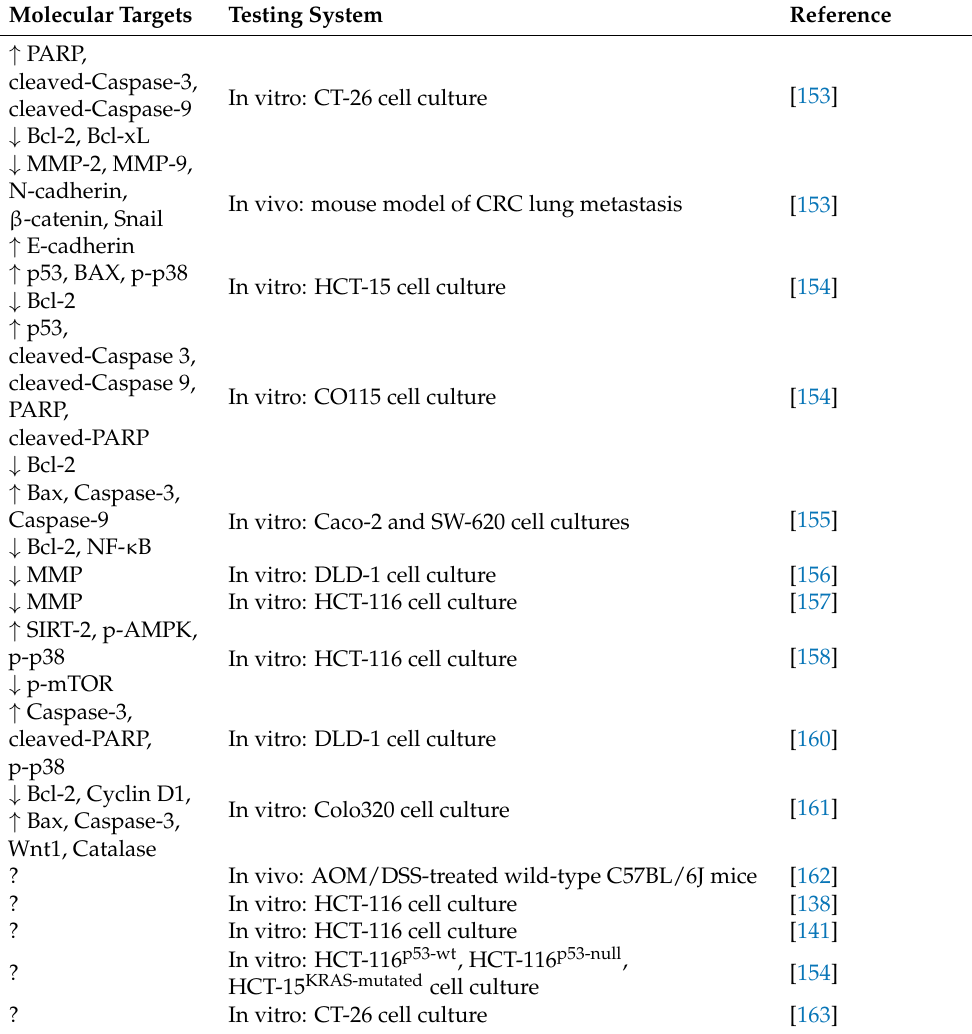
Table 5. Cont. Molecular